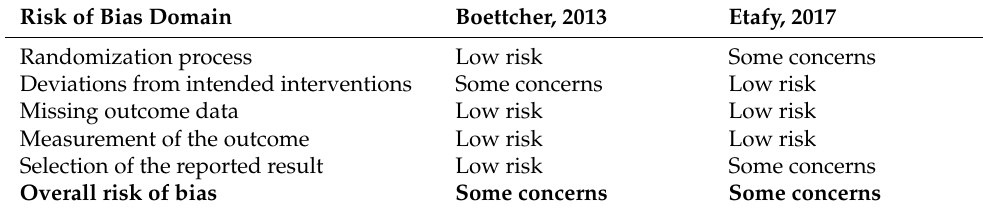
Table 3. Risk of bias for randomized controlled studies (RoB 2).